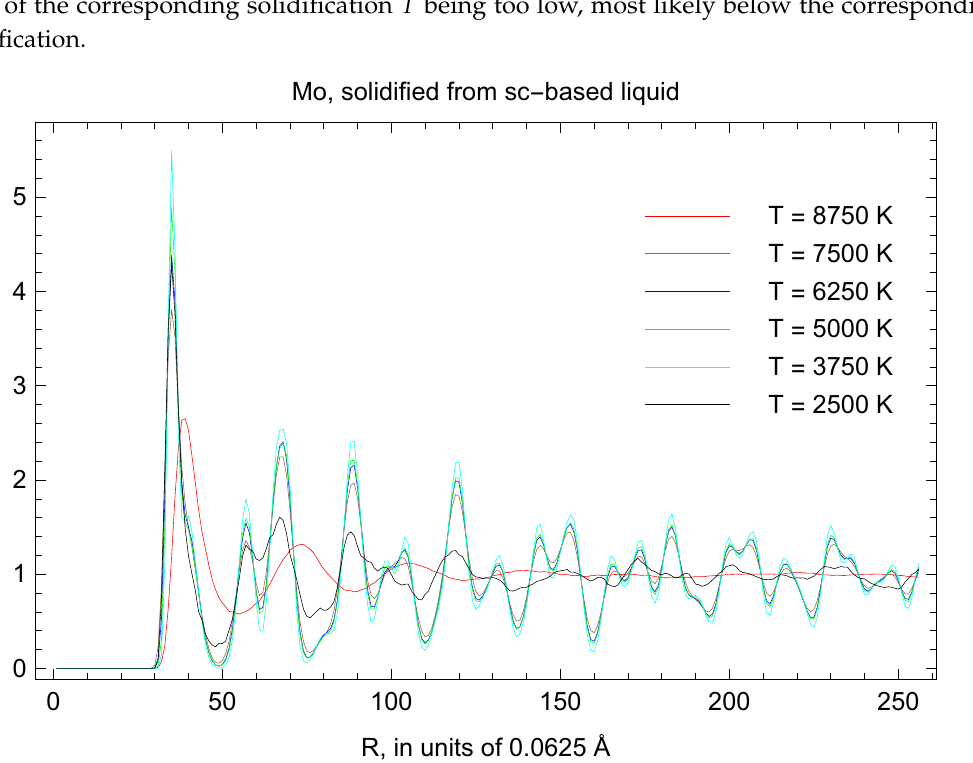
Figure 12. RDFs of the final states of the solidification of liquid Mo at ∼ 700 GPa at higher